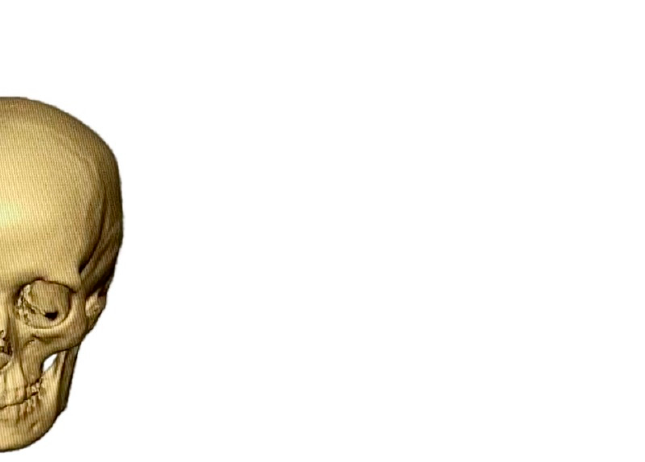
Figure 3. Superimposition strategy. Patient skull after virtual planning of PSI-based orthognathic surgery (gray) and standard skull (beige).